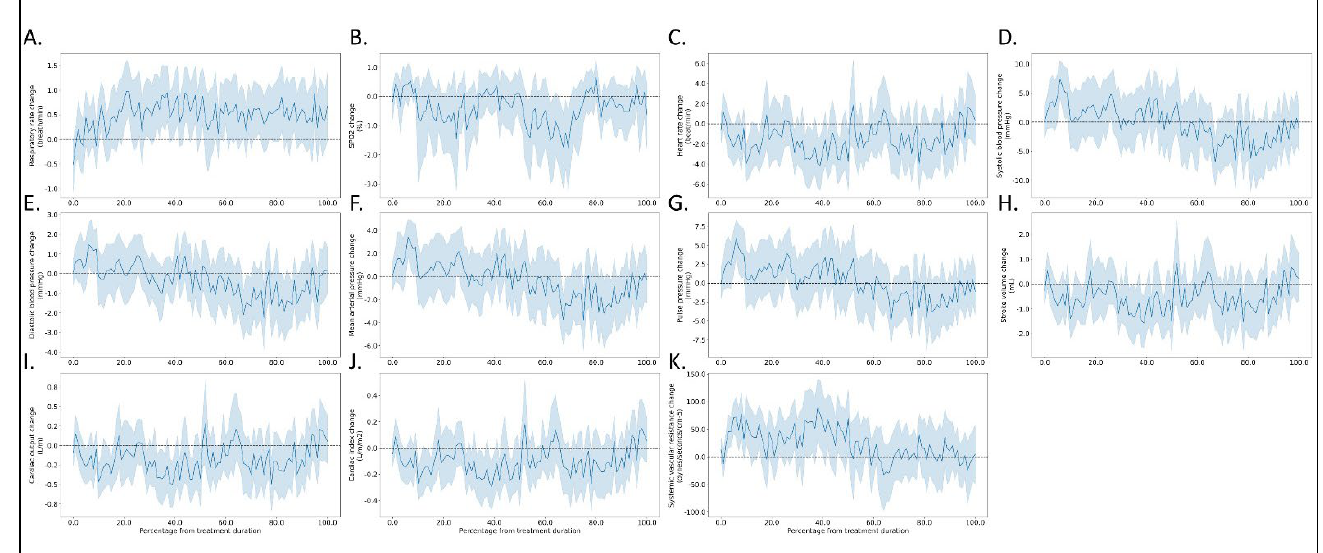
Figure 2. Relative changes from baseline in measured parameters during intravenous diuretic treatment. ( A ) respiratory rate (RR), ( B ) blood oxygen saturation (SPO 2 -%), ( C ) systemic vascu- lar resistance (dynes/sec/cm − 5 ), ( D ) heart rate (beats per minute), ( E ) stroke volume (milliliters), ( F ) cardiac output (liter/minute), ( G ) cardiac index (liter/minute/body surface area), ( H ) systolic blood pressure (mmHg), ( I ) diastolic blood pressure (mmHg), ( J ) pulse pressure (mmHg), ( K ) mean arterial pressure (mmHg).